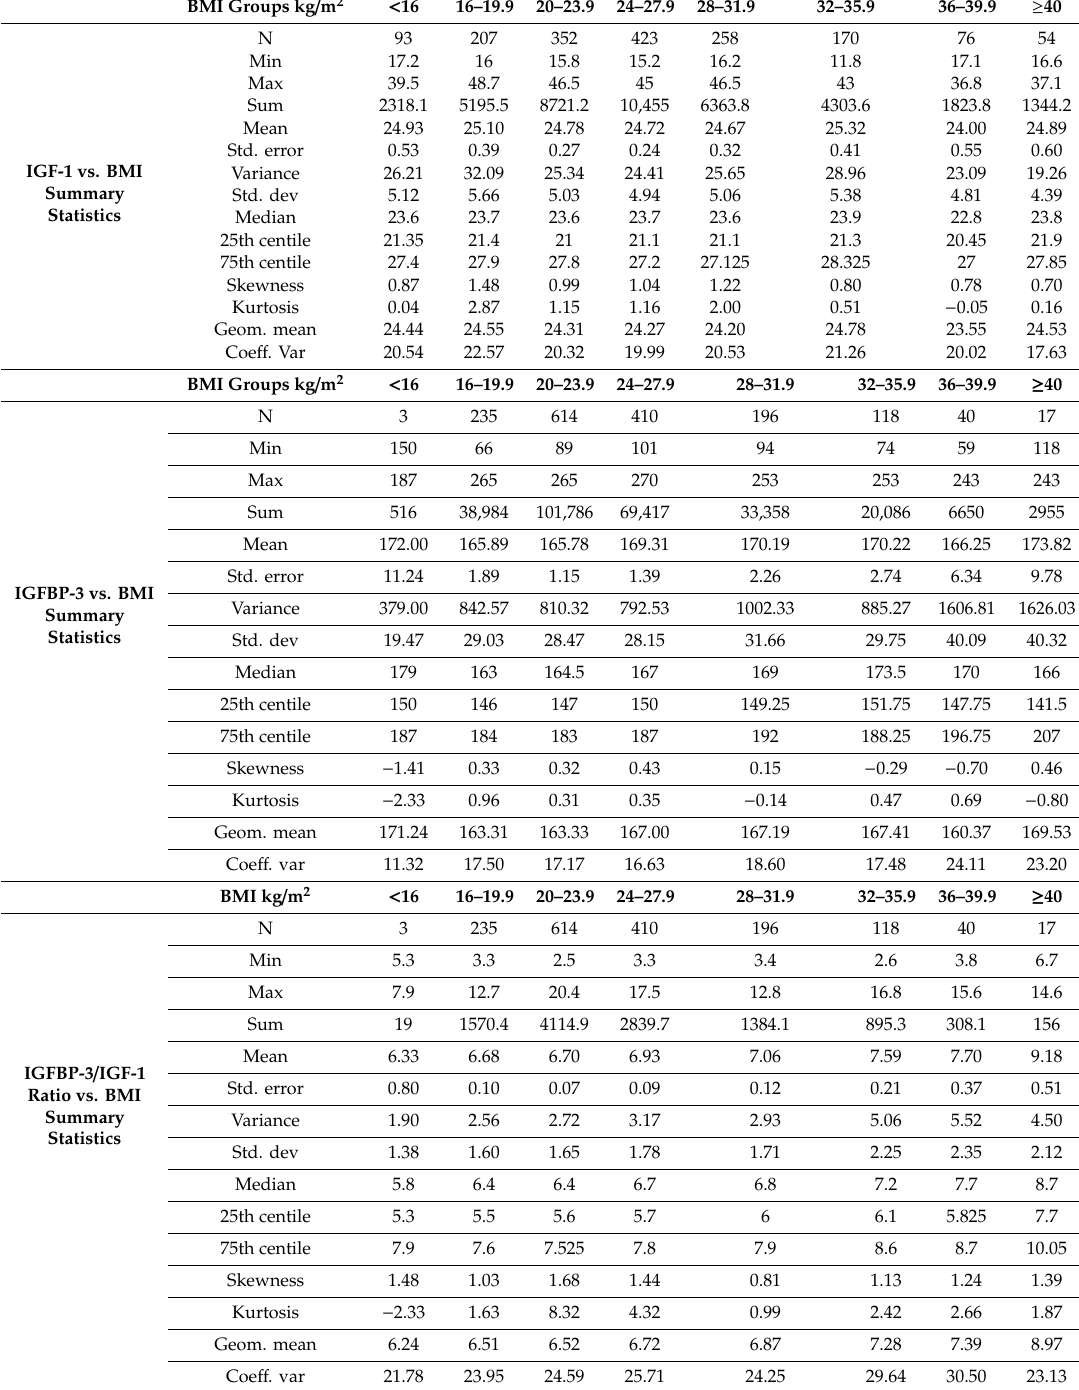
Table 3. Summary statistics are shown for the 1633 women stratified according to BMI groups and depicted in Figure 4. Applying the same statistical profile depicted in Table 1, now sub-categorized for the 8 BMI groups with respect to IGF-1 levels, IGFBP-3 levels and the IGFBP-3 / IGF-1 ratio. Noting there are only small numbers of cases in the lowest and highest BMI groups, there are no significant di ff erences in the mean levels, the medians or the inter-quartile ranges across the BMI